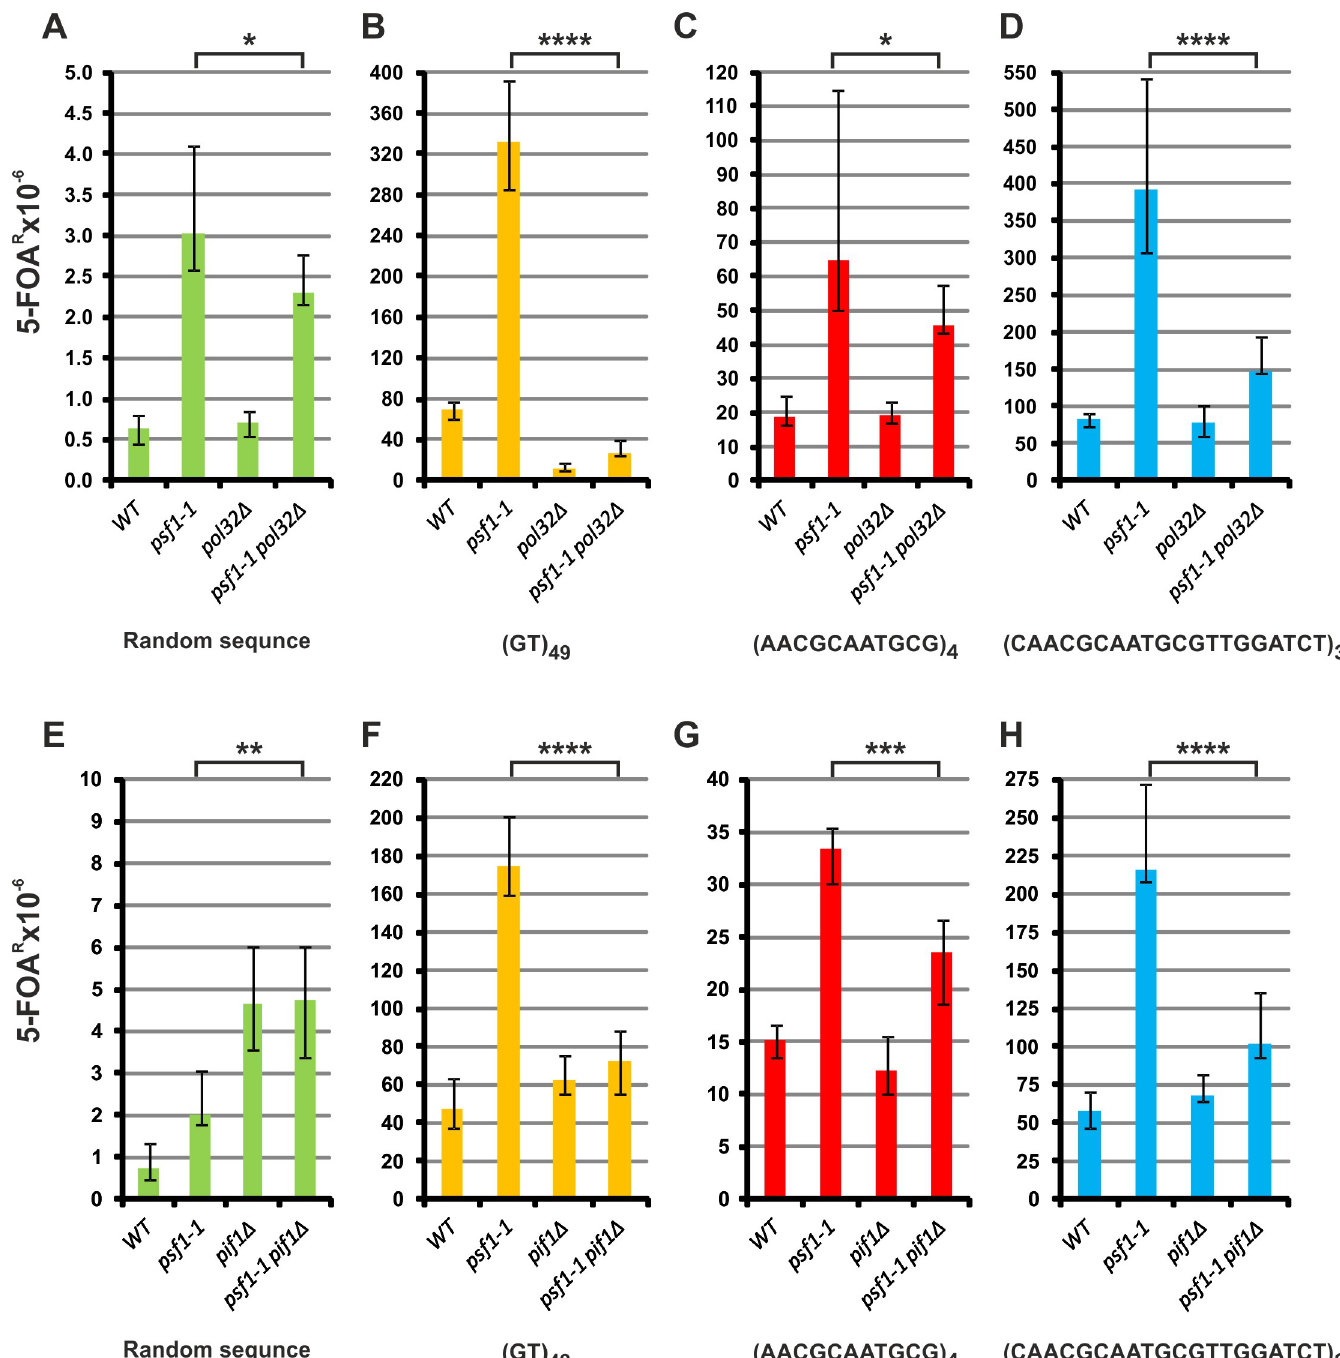
Fig 8. Break-induced replication contributes to the instability of repeat tracts in psf1-1 cells. (A-D) Impact of POL32 disruption. (E-H) Impact of PIF1 disruption. The 5-FOA R mutation rates were determined at 28˚C for yeast cells with the indicated genotypes carrying plasmids with the analyzed sequences; the values are medians with 95% confidence intervals calculated from data for at least ten cultures of each strain; the p values for psf1-1 pol32 Δ or psf1-1 pif1 Δ versus psf1-1 mutants versus wild-type strains were calculated using the nonparametric Mann-Whitney U statistical test ( ���� p � 0.0001; ��� p � 0.001; �� p � 0.01; � p � 0.05). All associated p -values are presented in the S1